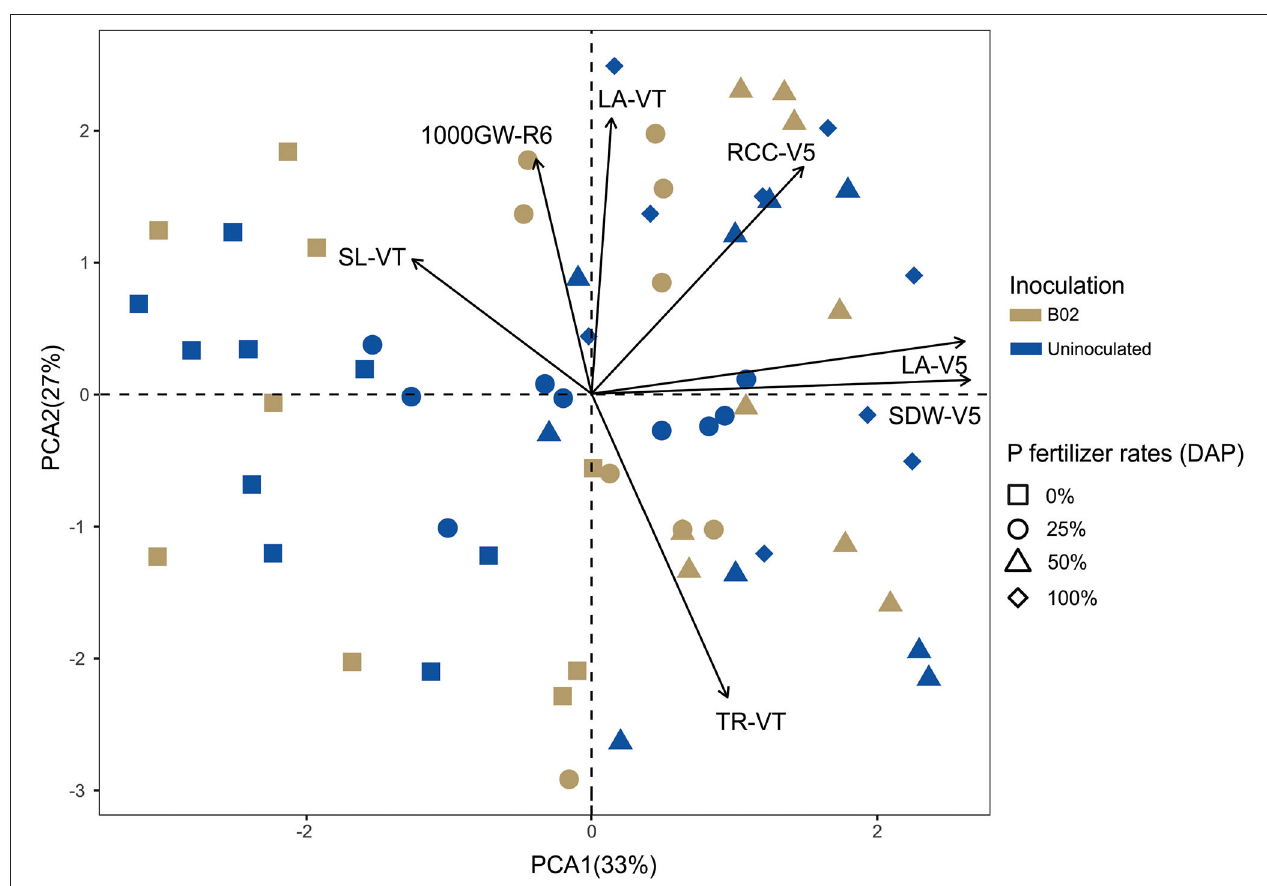
FIGURE 8 | Principal component analysis plot correlating morphometric, physiological, and productivity parameters promoted by inoculation with Rhizobium sp. B02 in the yellow endosperm genotype of maize. SDW, shoot dry weight; LA, leaf area; RCC, relative chlorophyll content; SL, shoot length; TR, transpiration rate; 1,000 GW, 1,000-grain weight; GY, grain yield; V5, vegetative stage of the tillering; VT, vegetative state of the tassel; R6, reproductive stage of physiological